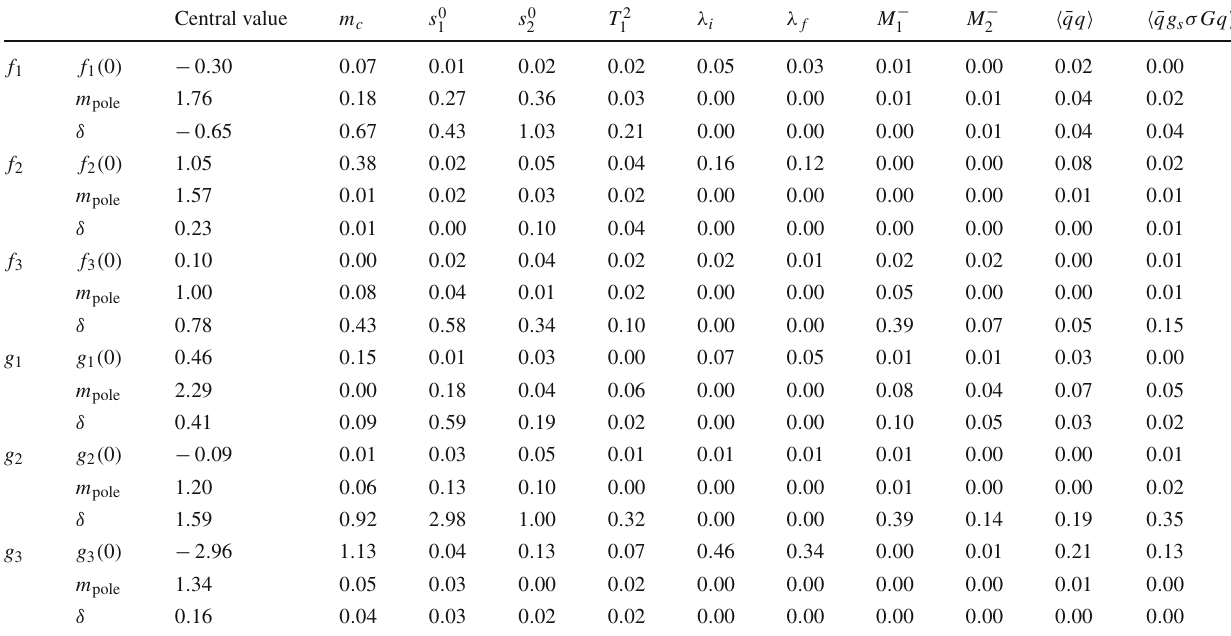
Table 14 The error estimates of the form factors for (cid:2) ++ cc → (cid:6) +